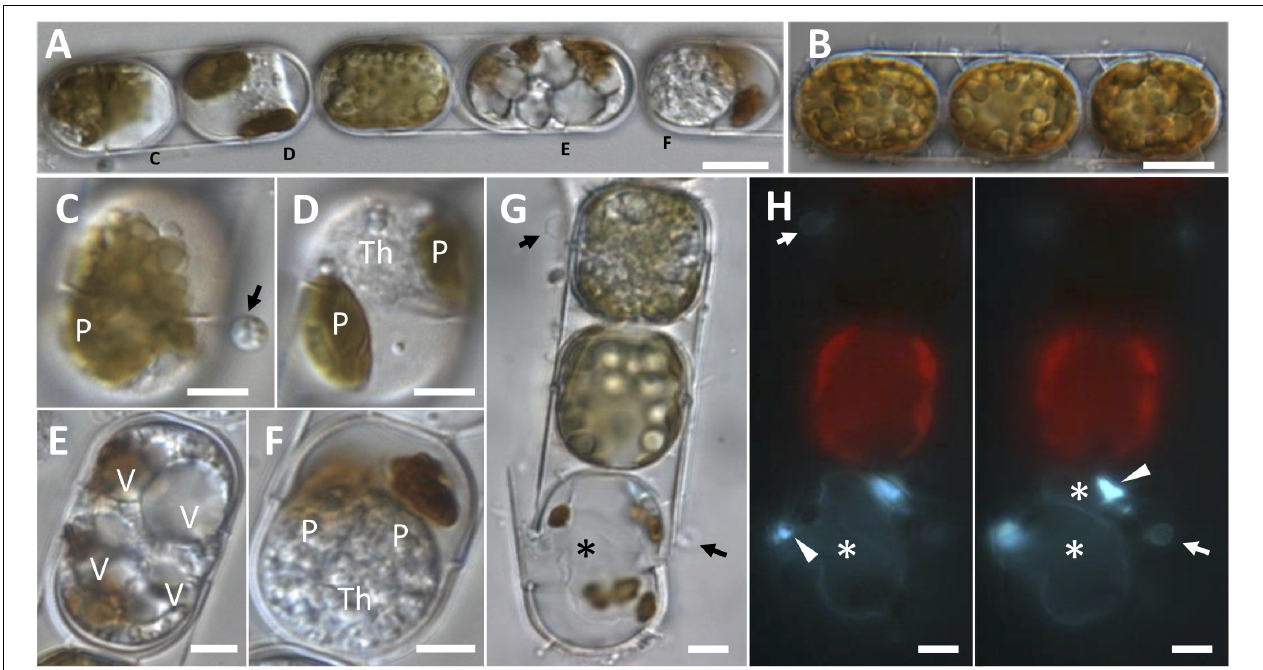
FIGURE 2 | Morphological characterisation of a novel oomycete parasitoid of Melosira cf. nummuloides. (A,B) . Highly infected diatom chain (A) , compared to a healthy one (B) . (C) Early stage of infection, with a spore (arrow) bearing refractive globules, encysted on a diatom frustule. (D) Unwalled thallus developing within the host cell, the once numerous small plate-like plastids are collapsed in two olive-green masses. (E) Highly vacuolised parasitic thallus filling the host cell almost entirely. (F) Mature spherical multinucleate thallus filling most of the host cell, the disrupted plastids are represented by two brown masses. (G,H) Bright field (G) and epifluorescence ( H , Calcofluor-White staining) microscopy of an uninfected cell (top) and a dead cell bearing one empty sporangium (bottom, asterisk) and an encysted spore (arrow). At a different focal plan ( H , right panel), a second smaller parasitic sporangium was discernible (top asterisk). Sporangial wall thickenings in correspondence of the discharge tube were also visible (arrowheads). (A,C–F) Refers to the single infected colony sequenced to obtain M . cf. nummuloides parasitoid Melo1para sequence. P, plastids; V, vacuole; Th, thallus. Scale bars: 10 µ m in (A,B) ; 5 µ m from (C–H) .